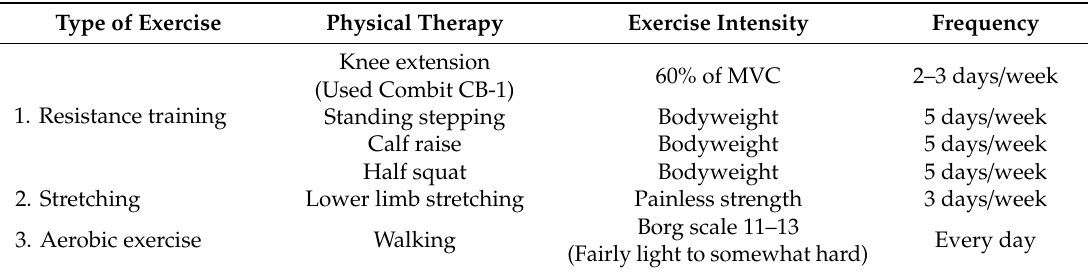
Table 1. A protocol of physical therapy for patients with hepatocellular carcinoma